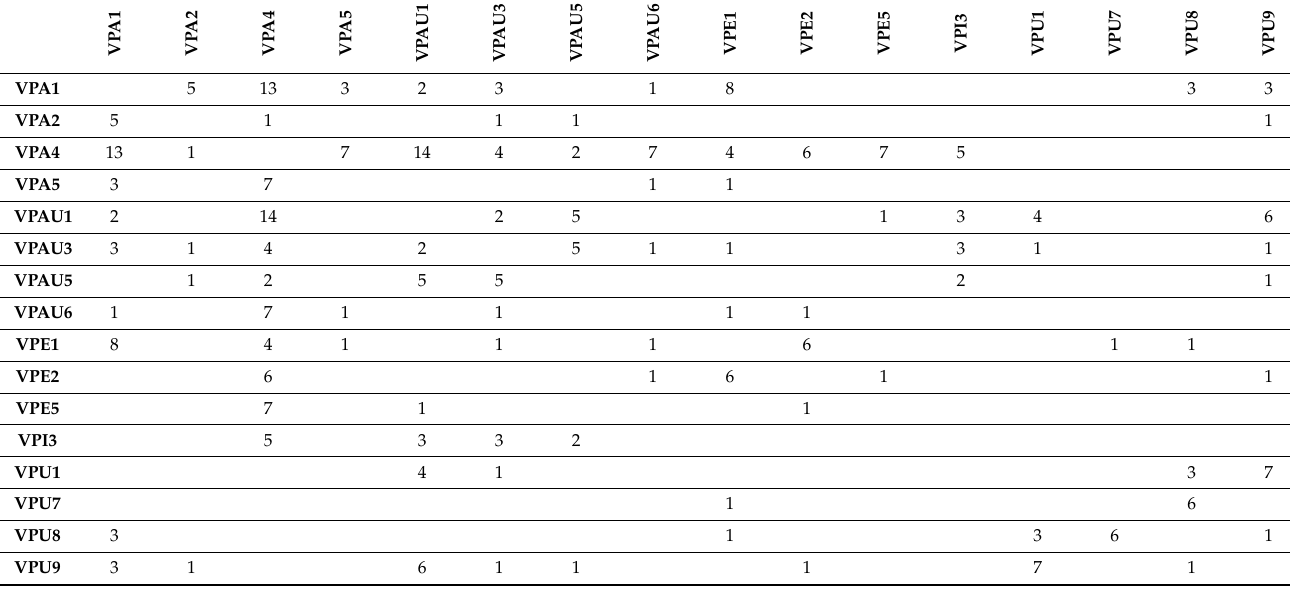
Figure 2. Map of maximum and minimum disadvantages by category/code (R: rooting; D: density). Table 3. Co-occurrence of the opinions of the students with respect to the advantages of the digital